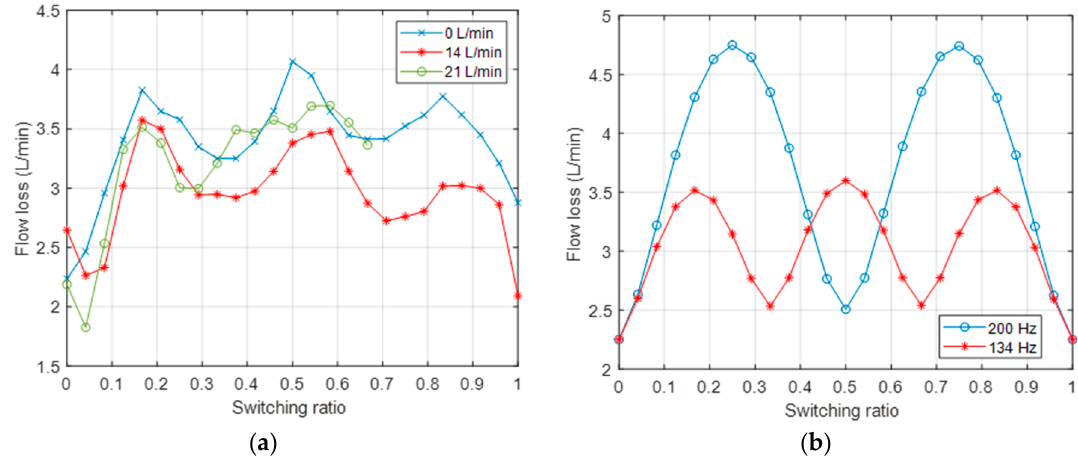
Figure 5. (a) Experiment flow losses with delivery-flow rate of 0, 14, and 21 L/min, and switching frequency of 200 Hz./ ( b ) Analytical estimations with switching frequency of 200 and 134 Hz.